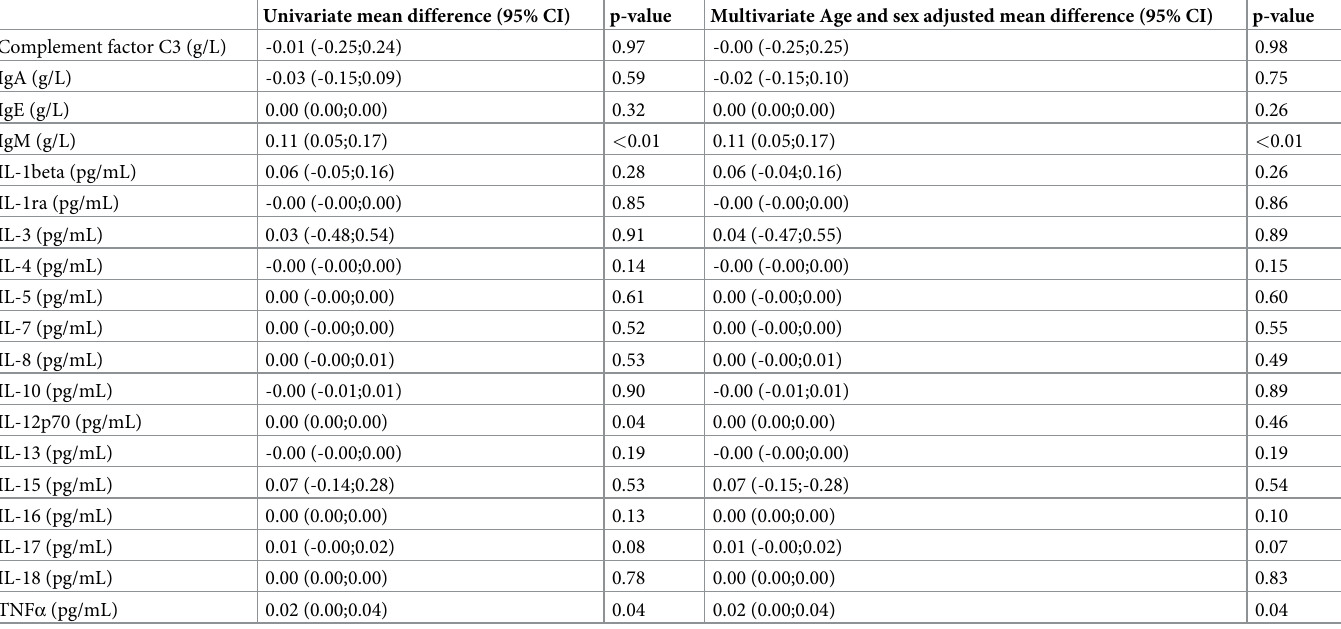
Table 3. Associations between MPO-DNA complex and inflammatory and immunology markers in a subset of 1208 individuals of RS-I-3. Univariate mean difference (95%